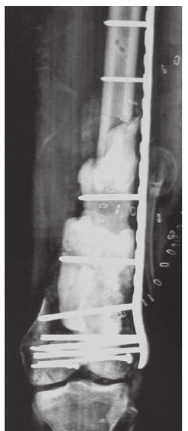
Figure 1: Original injury depicting 17 cm of segmental bone loss in the distal metadiaphyseal aspect of the right femur.